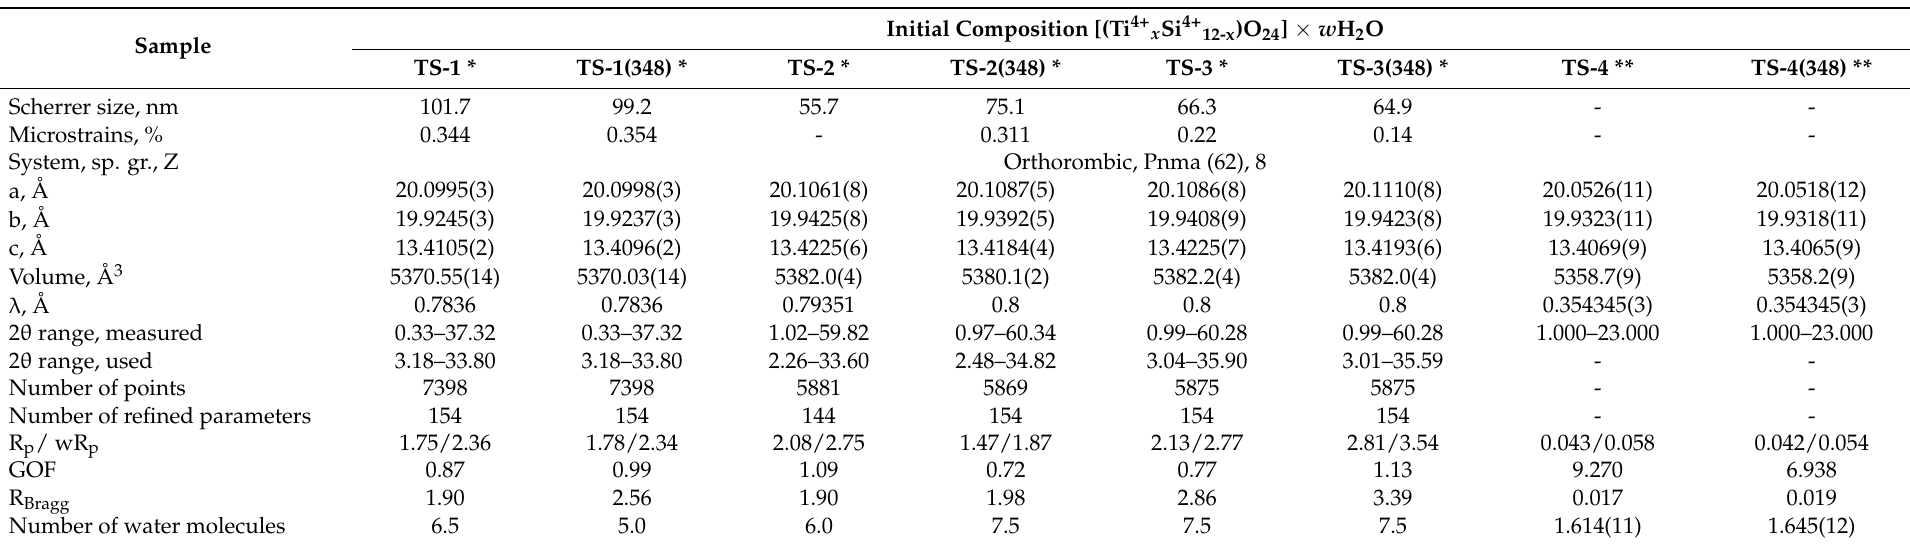
Table 11. Crystallographic data of TS-1, TS-2, TS-3, TS-4, TS-1(348), TS-2(348), TS-3(348), and TS-4(348) (data from